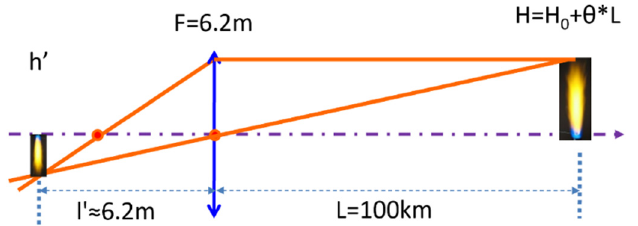
Figure 3. Geometric Optics diagram of the imaging the Na layer using a Cassegrain telescope with